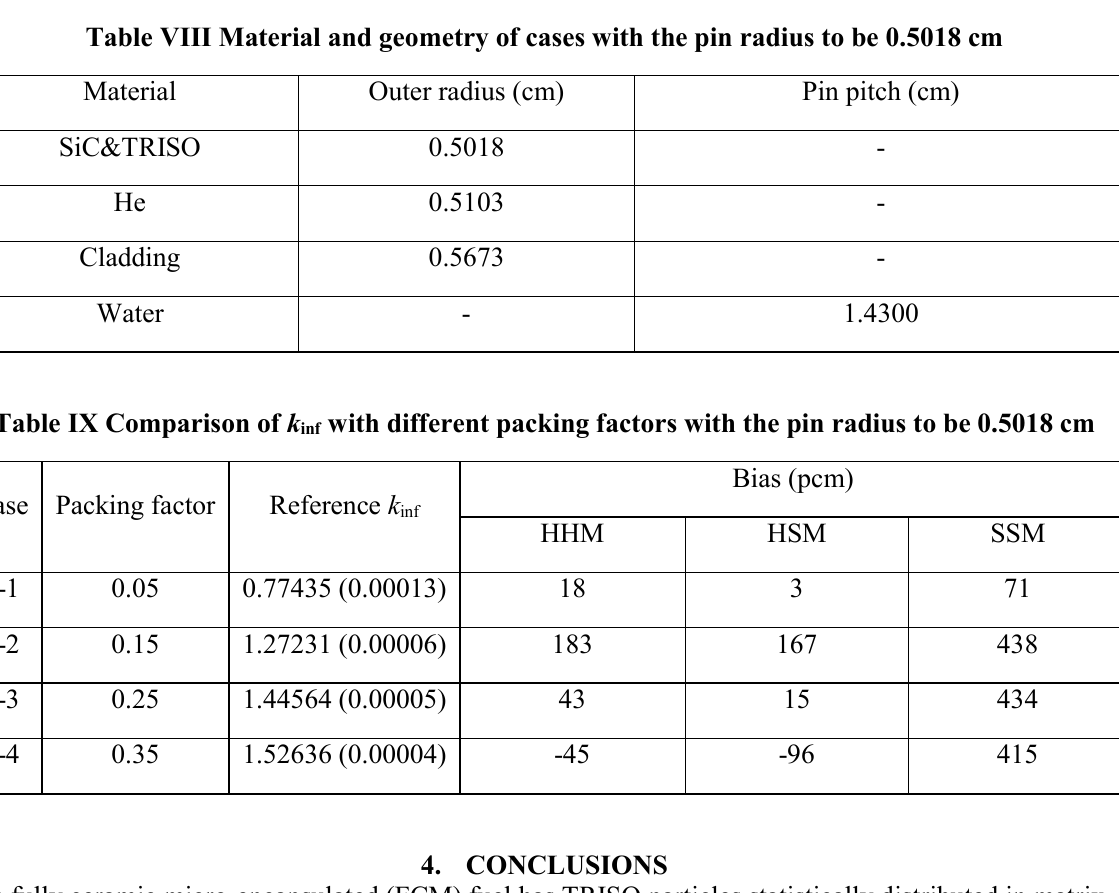
Table VII Comparison of k